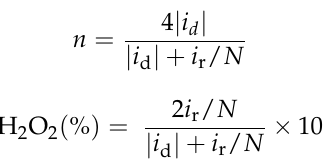
catalyst; Figure S3: The pore size distribution of the obtained NC and Co-N-C catalysts; Figure S4: Co 2p peaks and fitting results of (a) Co-N-C-1, and (b) Co-N-C-3; Figure S5: N 1s peaks and fitting results of (a) N-C, (b) Co-N-C-1, and (c) Co-N-C-3; Figure S6: The yield of hydrogen peroxide (%) and electron transfer number of the Co-N-C-2 catalyst toward ORR; Table S1. Pore features of the N-C and Co-N-C catalysts; Table S2. Surface elemental composition (wt.%) of the obtained materials measured by XPS; Table S3. Content of each nitrogen component (%) of the N-C and Co-N-C catalysts; Table S4. Comparison of the ORR catalytic performance of the Co-N-C-2 SACs catalyst and the other M-N-C catalysts reported in the literature in 0.1 M KOH. References [35,36,38,40–47,50–58] are cited in Supplementary